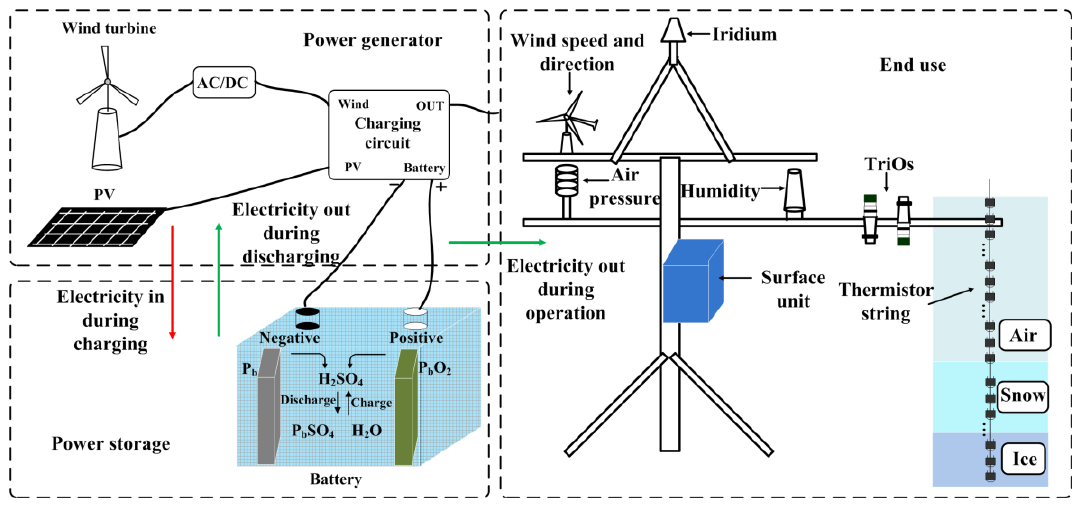
Figure 5. Schematic of the power-supply system.